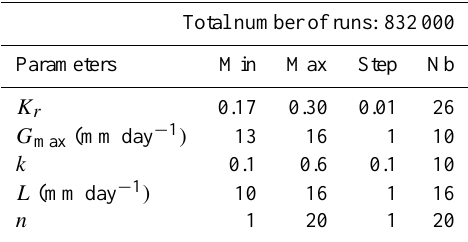
Table 3. Calibration experimentation